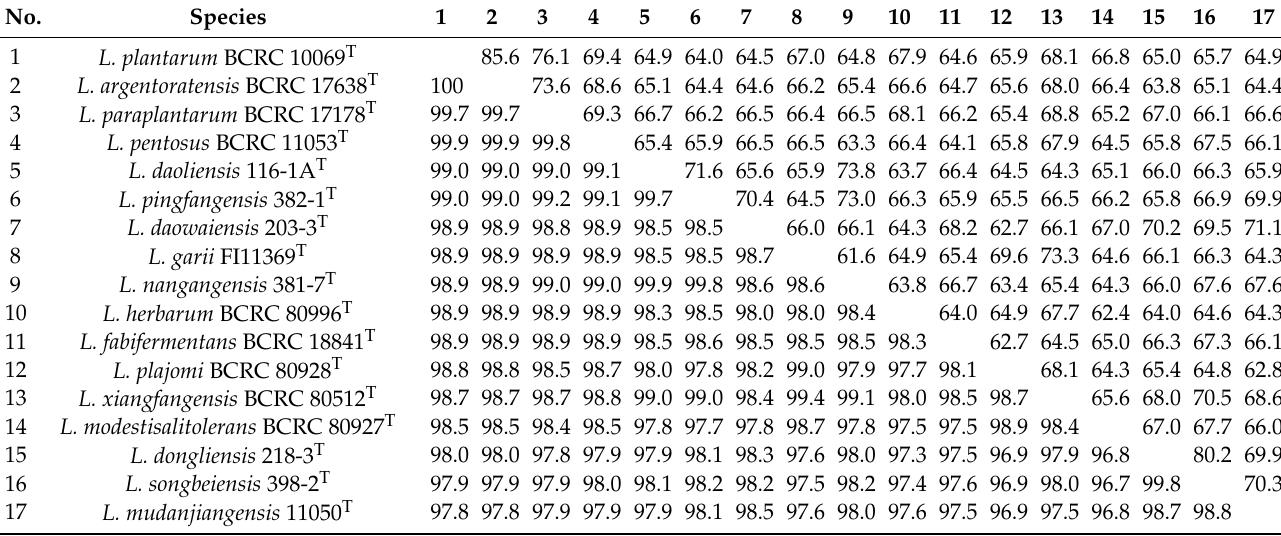
Table 2. Identities of mutL and 16S rDNA sequences between the type strains of the L. plantarum group. No.